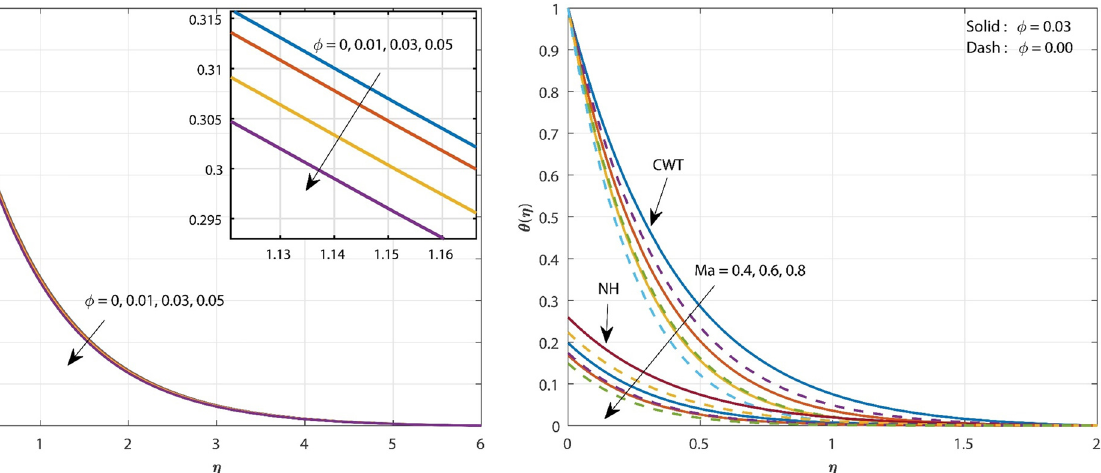
Figure 6: Plot of θ ( η ) over di ff erent values of